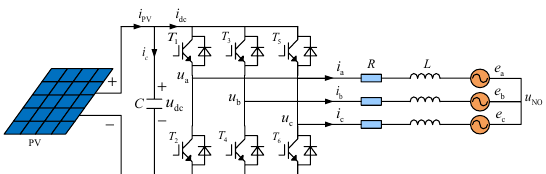
Fig. 1 Topological structure of grid-connected PV power generation